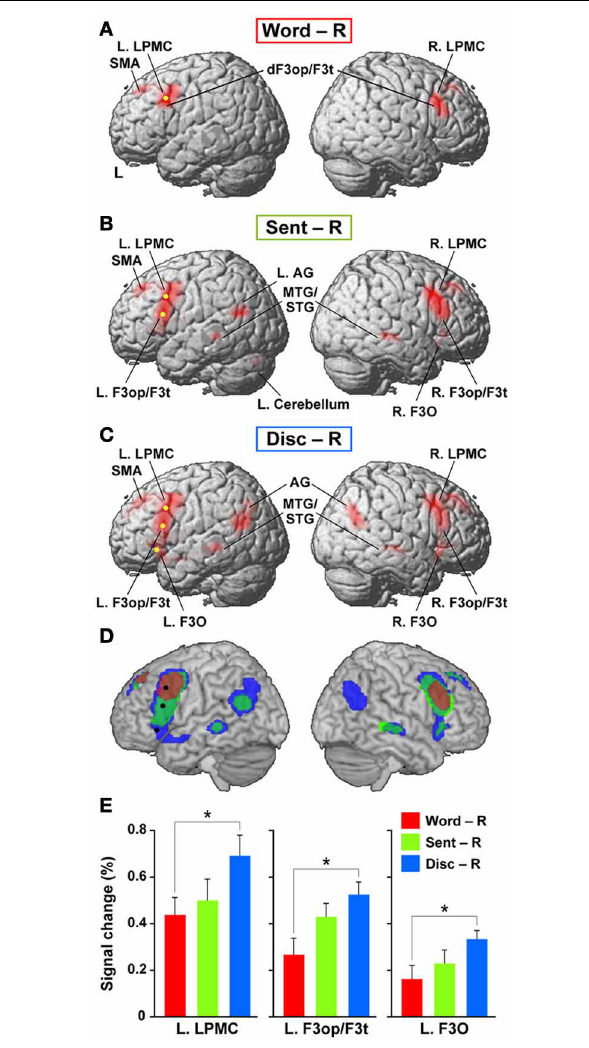
FIGURE 2 | Cortical activations modulated by the levels of linguistic integration. (A–C) Cortical activations in each of the Word (A) , Sent (B) , and Disc (C) tasks, compared with the R task, are projected onto the lateral surfaces of a standard brain in the MNI space. Significantly activated regions are shown in red (FDR-corrected p < 0 . 05). Note the most prominent activation in the frontal language areas. (D) An overlaid map of cortical activations in Word − R (red), Sent − R (light green), and Disc − R (blue), using transparent overlays in this order (Word − R topmost). For example, when a region was activated in both Sent − R and Disc − R, its color became blue-green (see the region in the right temporal cortex). Note the gradual expansion of activation from the dorsal to ventral regions within the frontal language areas. We focused on three regions in the frontal language areas: the L. LPMC, L. F3op/F3t, and L. F3O [shown as yellow dots in (A–C) , and as black dots in (D) ]. (E) Signal changes of each local maximum for Word − R (red), Sent − R (light green), and Disc − R (blue). Error bars indicate the SEM of participants, and asterisks denote the significance level of corrected p < 0 .